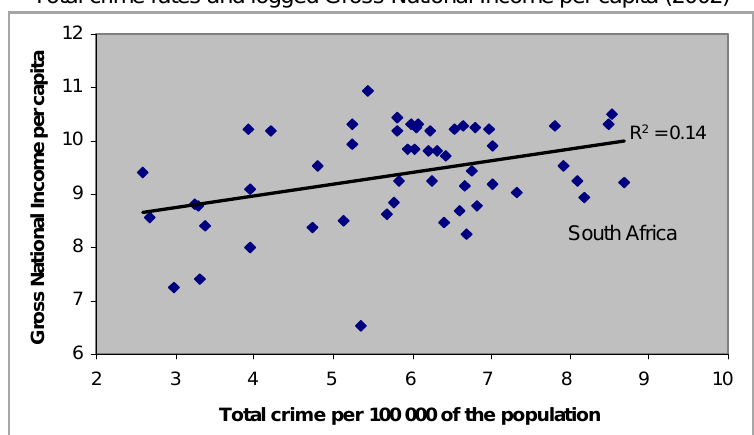
Total crime rates and logged Gross National Income per capita (2002)